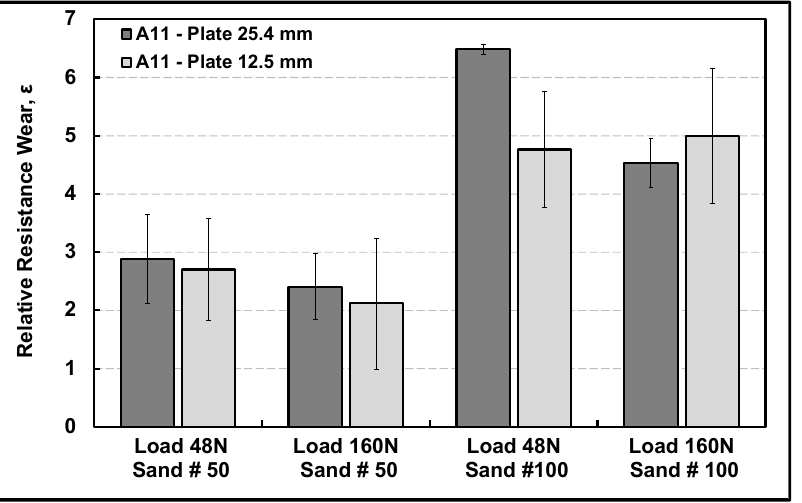
Figure 8. Relative abrasive wear resistance of Fe-Cr-C-V taken the commercial wear-resistant USI AR 450 steel as reference.